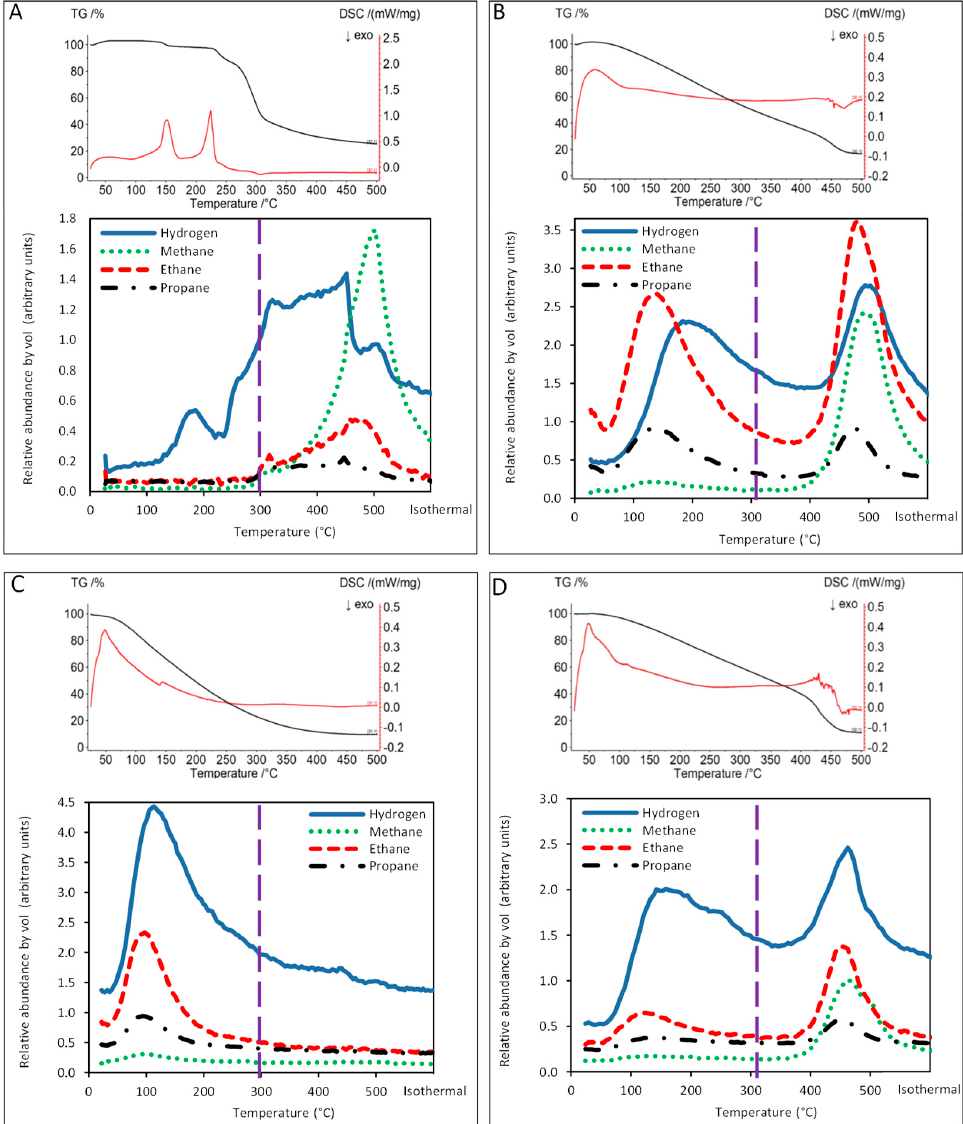
Figure 2. Pyrolysis of samples under humid carbon dioxide. Data for lactose ( A ), strategic petroleum reserve ( B ), Bakken ( C ), and Monterey Well 16 ‐ 31 ( D ). Each panel contains TGA/DSC data (upper) and MS data (lower). Exothermic peaks in the DSC appear as negative peaks. The dashed vertical line at 300 ◦ C is to illustrate that pyrolysis is not expected below this temperature so the indicated compositions are from a different source.